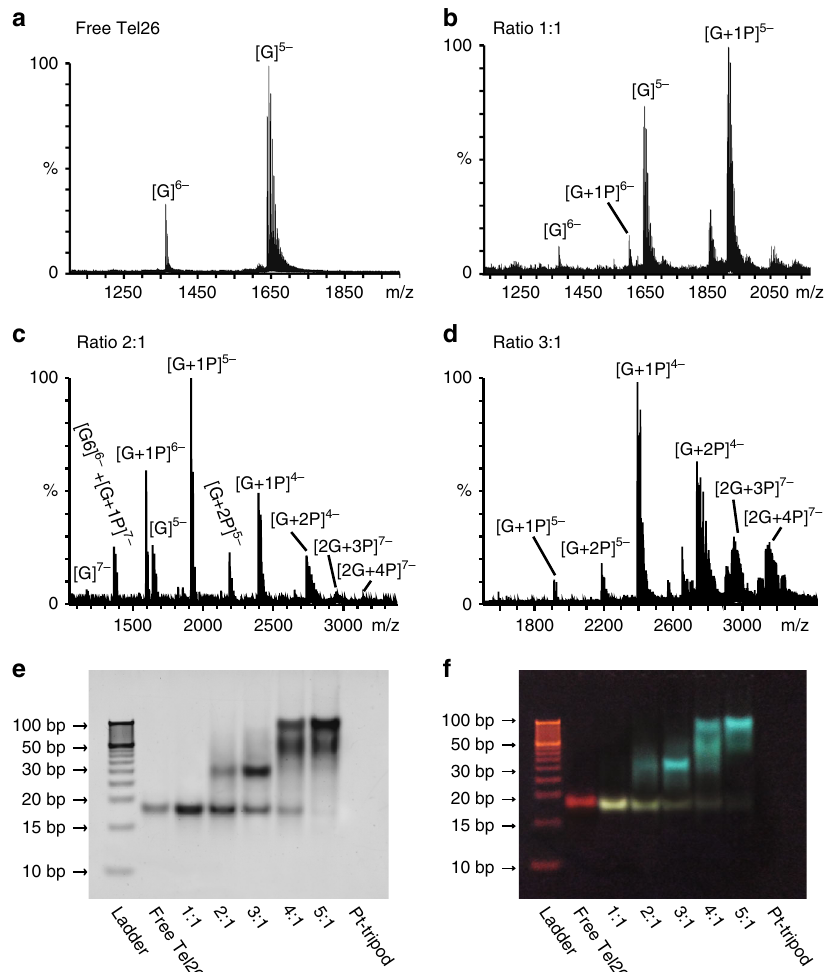
Fig. 2 The formation of monomeric and higher-order Pt-tripod – Tel26 complex structures. a – d The ESI-MS of the Pt-tripod interacting with the Tel26 with peaks labeled. ‘ G ’ means ‘ Tel26 Guadruplex ’ , and ‘ P ’ means ‘ Pt-tripod ’ . e , f The native PAGE of different ratios of the Pt-tripod with the Tel26. The gel pictures were photographed by the FluorChem M imager (ProteinSimple) and visualized by the UV light, respectively. The ratios of Pt-tripod/Tel26 are